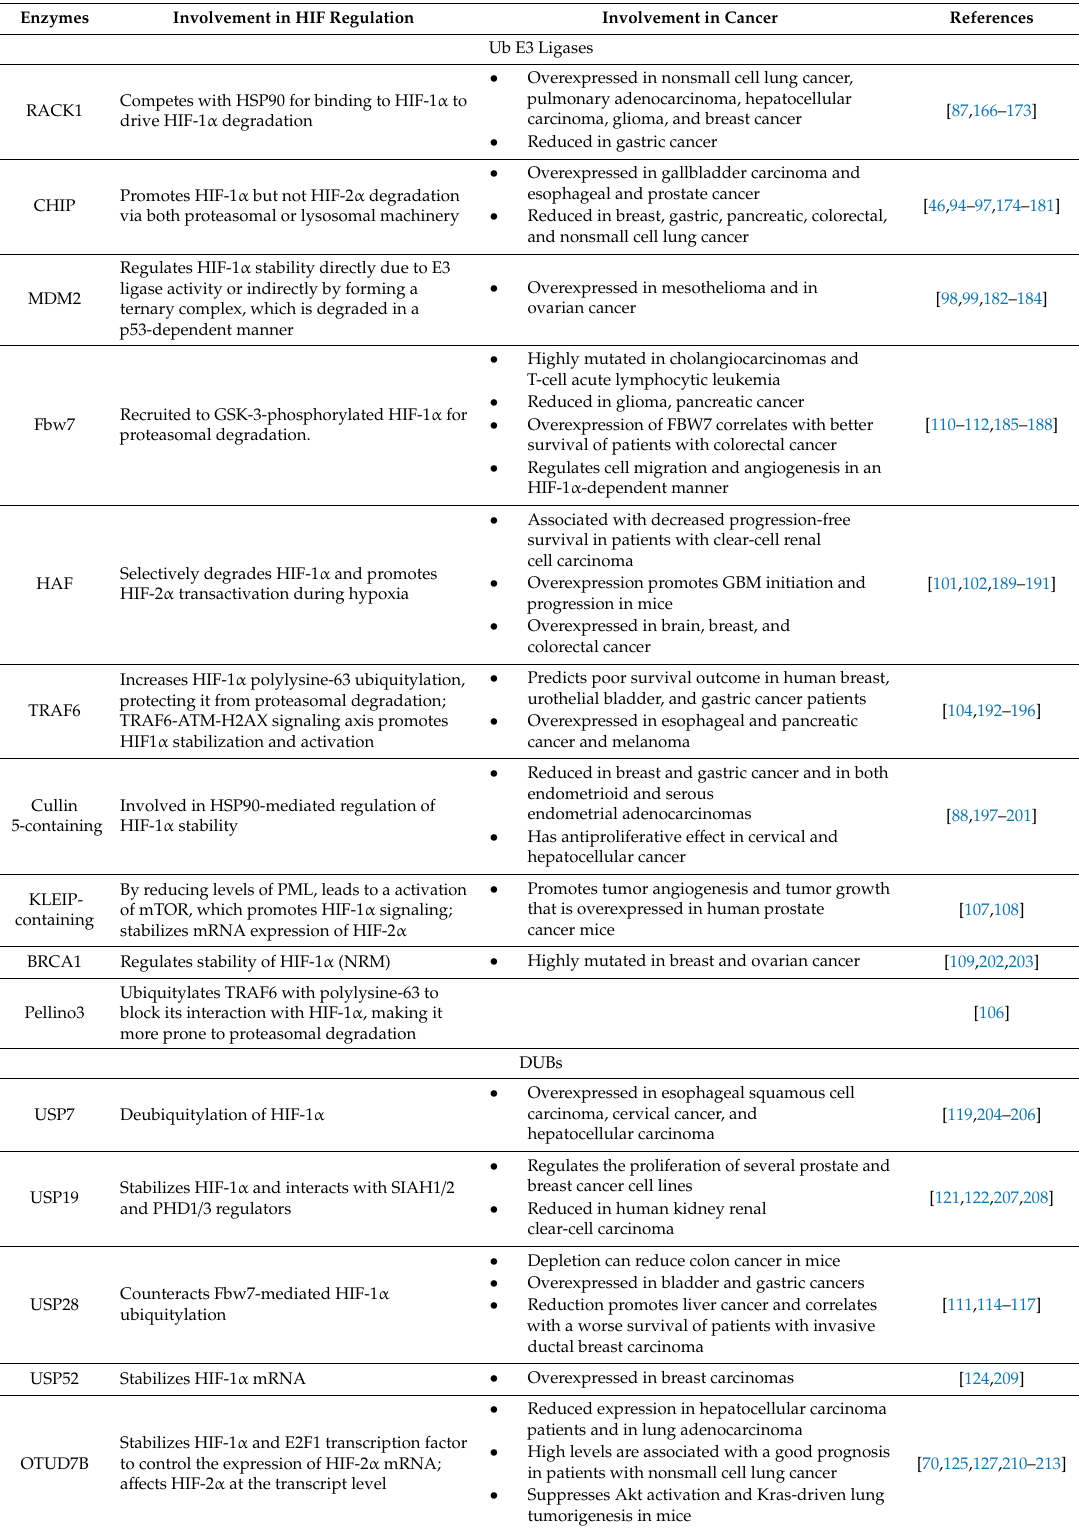
Table2. E3 ligases and DUBs a ff ecting the oxygen-independent regulation of HIFsand their involvement in